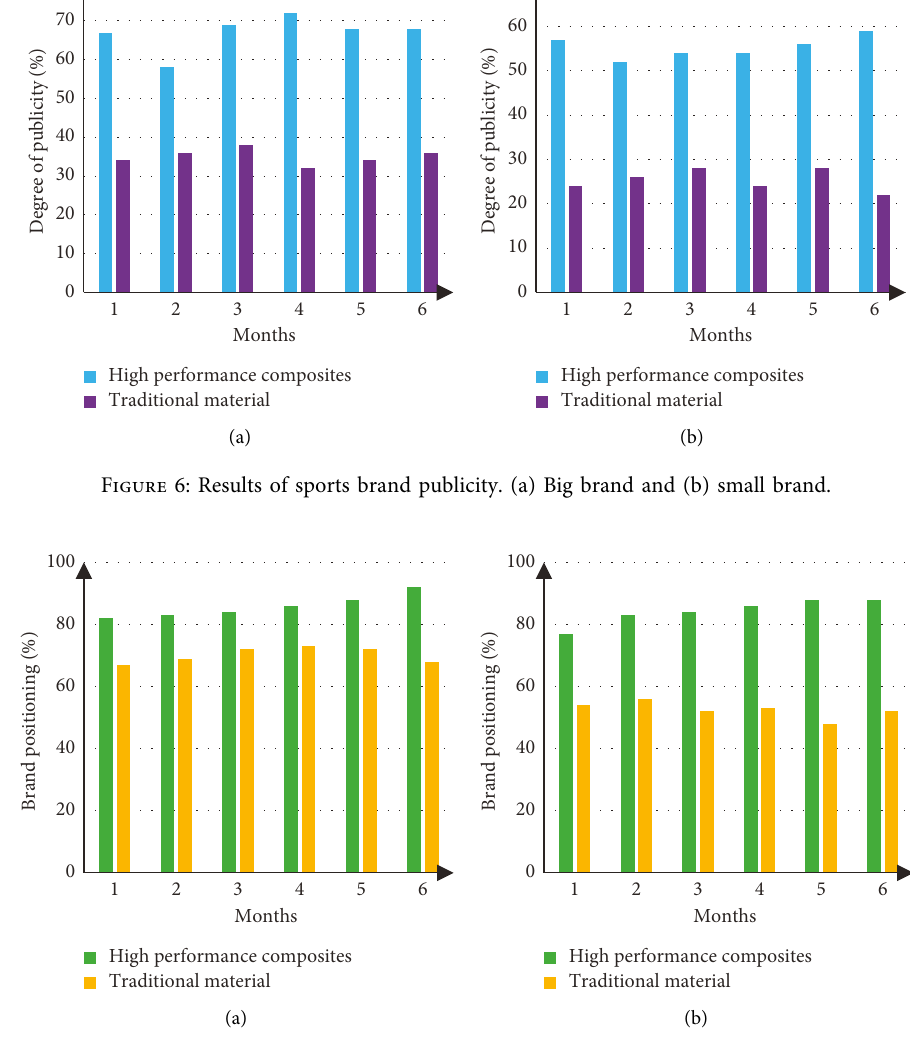
Figure 7: Comparison results of sports brand positioning. (a) Large-scale brands. (b) Small-scale